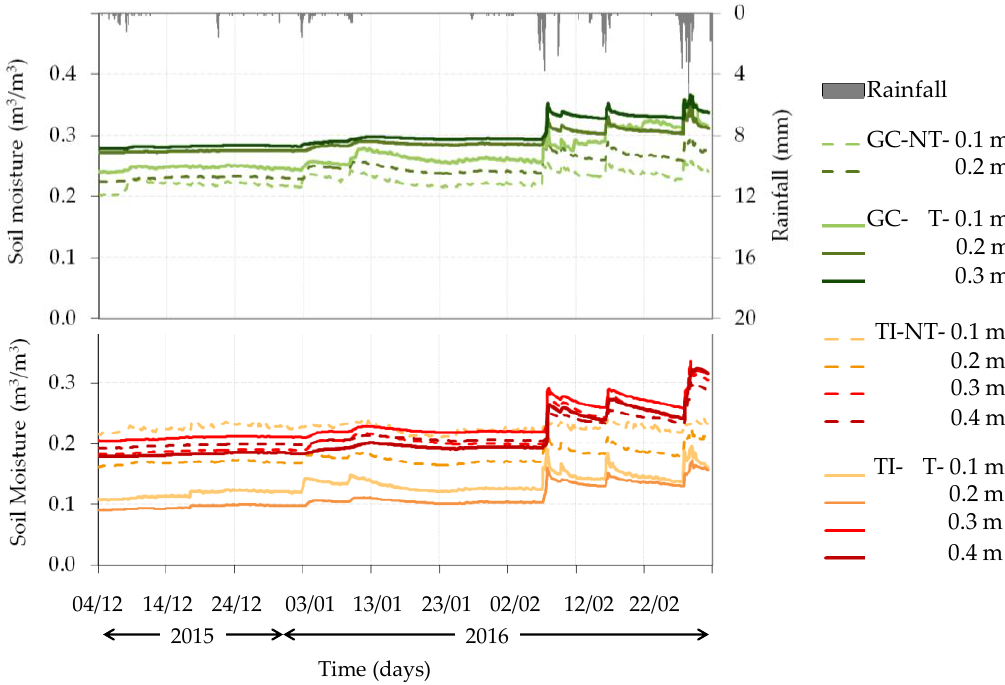
Figure 18. Carpeneto site, winter 2015–2016. Rainfall and soil moisture data collected with an hourly time step (from 0.1 to 0.4 m soil depths). Green lines refer to the Grass Cover condition (GC); red lines refer to the Conventional Tillage condition (TI). Dotted lines refer to the “No Track” condition (NT); solid lines refer to the “Track” condition (T).